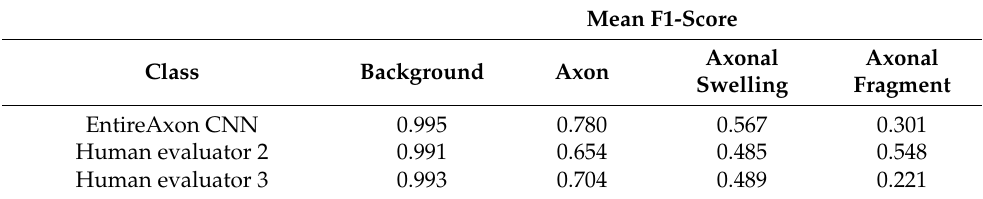
Table 2. Comparison of the mean F1 scores between the EntireAxon CNN and two human evaluators on the ground truth (human evaluator 1 also labeled the training images) to recognize background, axon, axonal swelling, and axonal fragments.